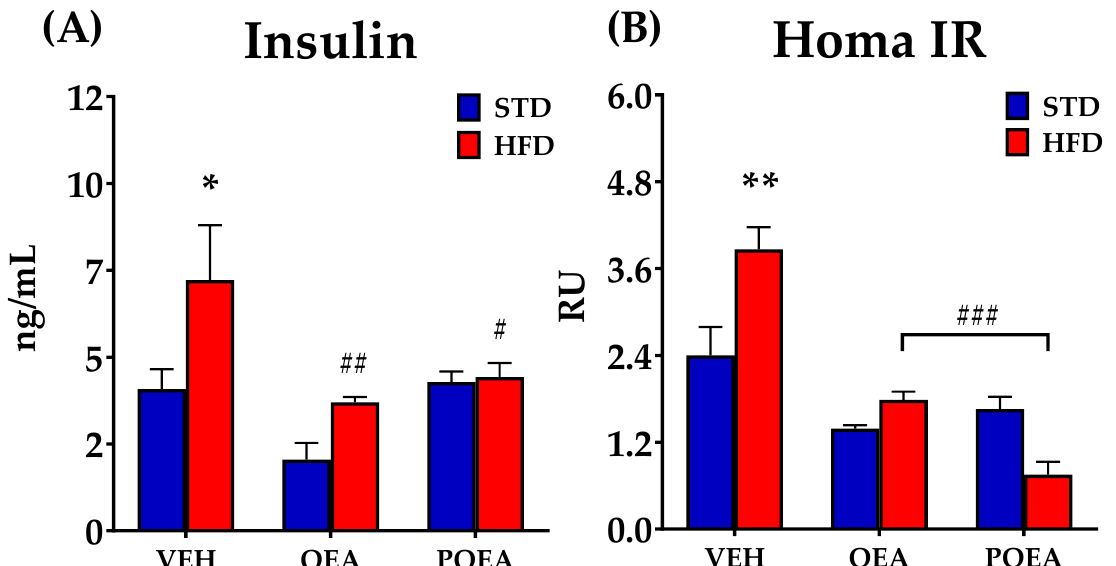
Figure 6. Effects of sub-chronic (15 days) administration of a 10 mg/kg dose of either oleoylethanolamide (OEA) or palmitoleylethanolamide (POEA). on the plasma levels of insulin ( A ) and analyzed the Homeostatic Model Assessment for Insulin Resistance (HOMA IR) ( B ) in male Sprague–Dawley rats. Data are expressed as means ± standard error of the mean (SEM) ( n = 8 animals/group) analyzed by two-way ANOVA (diet and treatment and Bonferroni post hoc test). (*) p < 0.05 and (**) p < 0.01 significant differences compared with standard diet (STD) vehicle (VEH) group; (#) p < 0.05, (##) p < 0.01, and (###) p < 0.001 significant differences compared with hypercaloric cafeteria diet (HFD) VEH group.